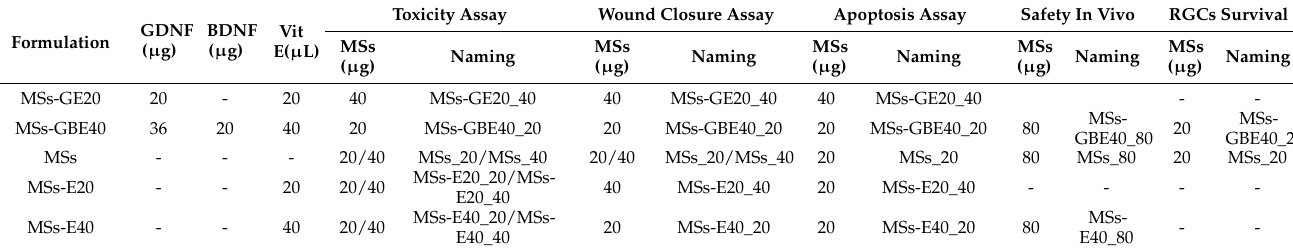
Table 2. Microsphere (MS) formulations and amount of tested MSs in each